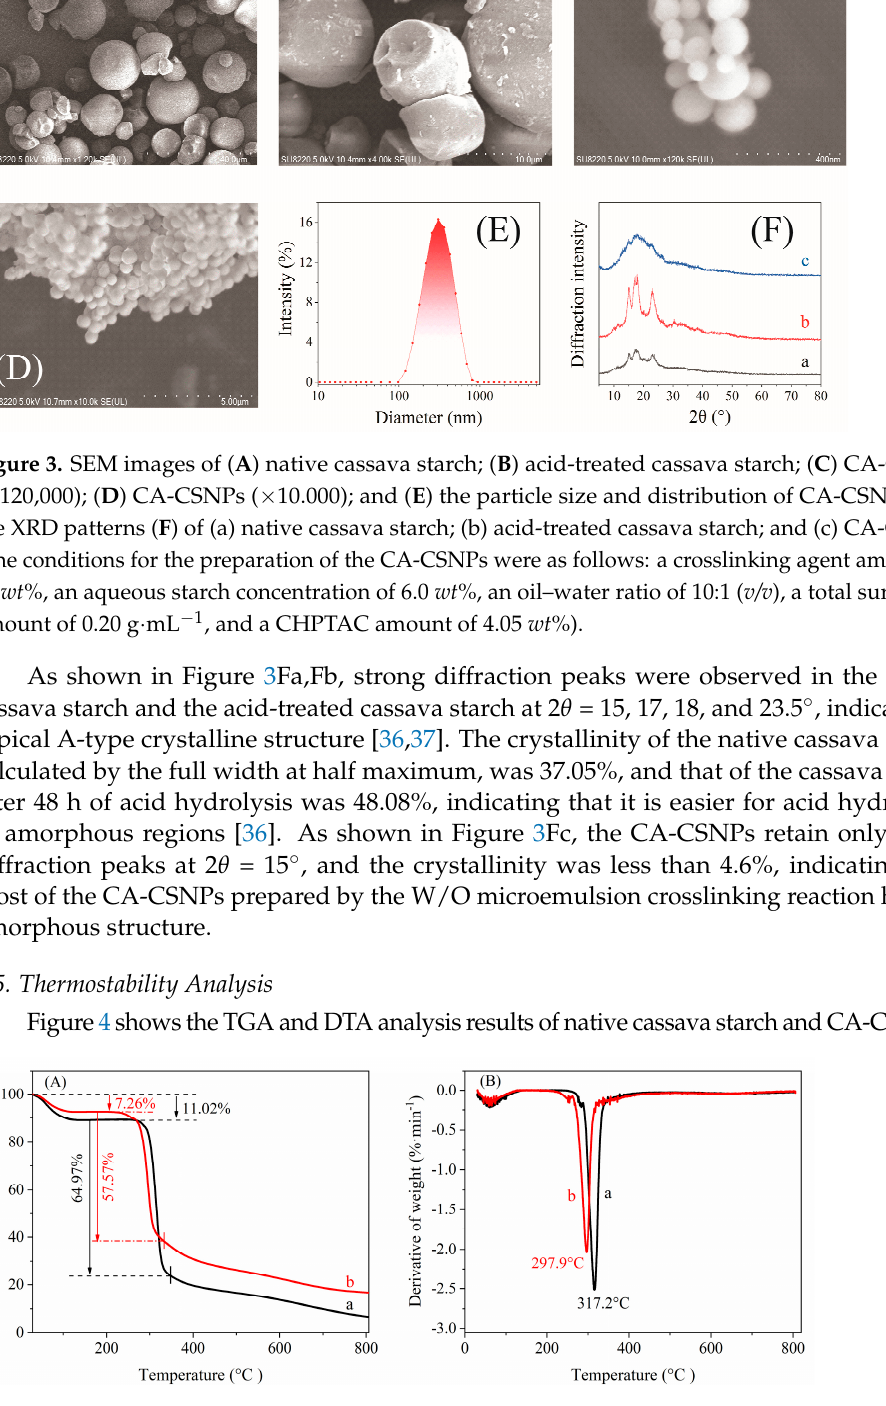
Figure 4. TGA ( A ) and DTA ( B ) of (a) native cassava starch and (b) CA ‐ CSNPs. As shown in Figure 4, the maximum decomposition temperatures of native cassava starch and CA ‐ CSNPs are 317.2 and 297.9 °C, respectively. The results indicated that the thermal stability of CA ‐ CSNPs was only slightly decreased after acid pretreatment, cross ‐ linking, and amphoteric modification of native cassava starch in the W/O microemulsion. 3.6. Surface Charge and pH Response Analysis Figure 5A shows that the zeta potential of anionic cassava starch nanoparticles (A ‐ 1, r N/P = 0) is decreasing from − 1.12 to − 21.37 mV with the increasing of the pH value from 4 to 10, presenting only negative charge characteristics and no isoelectric point. For CA ‐ CSNPs (CA ‐ 1~CA ‐ 5), the zeta potential is also decreasing with the increase in the pH value from 4 to 10; however, the charge of CA ‐ CSNPs shifts from positive to negative. Thus, the corresponding pH value where the zeta potential value = 0 is the pI of CA ‐ CSNPs. In the left area of the pI line (Zeta = 0) shown in Figure 5B, the zeta potential of CA ‐ CSNPs is positive, and the CA ‐ CSNPs present a positive charge. In the right area of the pI line, the zeta potential of CA ‐ CSNPs is negative, and the CA ‐ CSNPs showed a neg ‐ ative charge. The results indicate that the CA ‐ CSNPs have a charge ‐ reversal function with a pH response, and the pH ‐ responsive value (pI) is increasing with the increase in the molar ratio of nitrogen to phosphorus. As shown in Table 2, when the molar ratio of ni ‐ trogen to phosphorus increases from 0.50 to 1.10, the pI of CA ‐ CSNPs increases from 4.79 to 10.32, which indicates that the pI of CA ‐ CSNPs is controllable by adjusting the molar ratio of the cationic and anionic groups on the CA ‐ CSNPs.